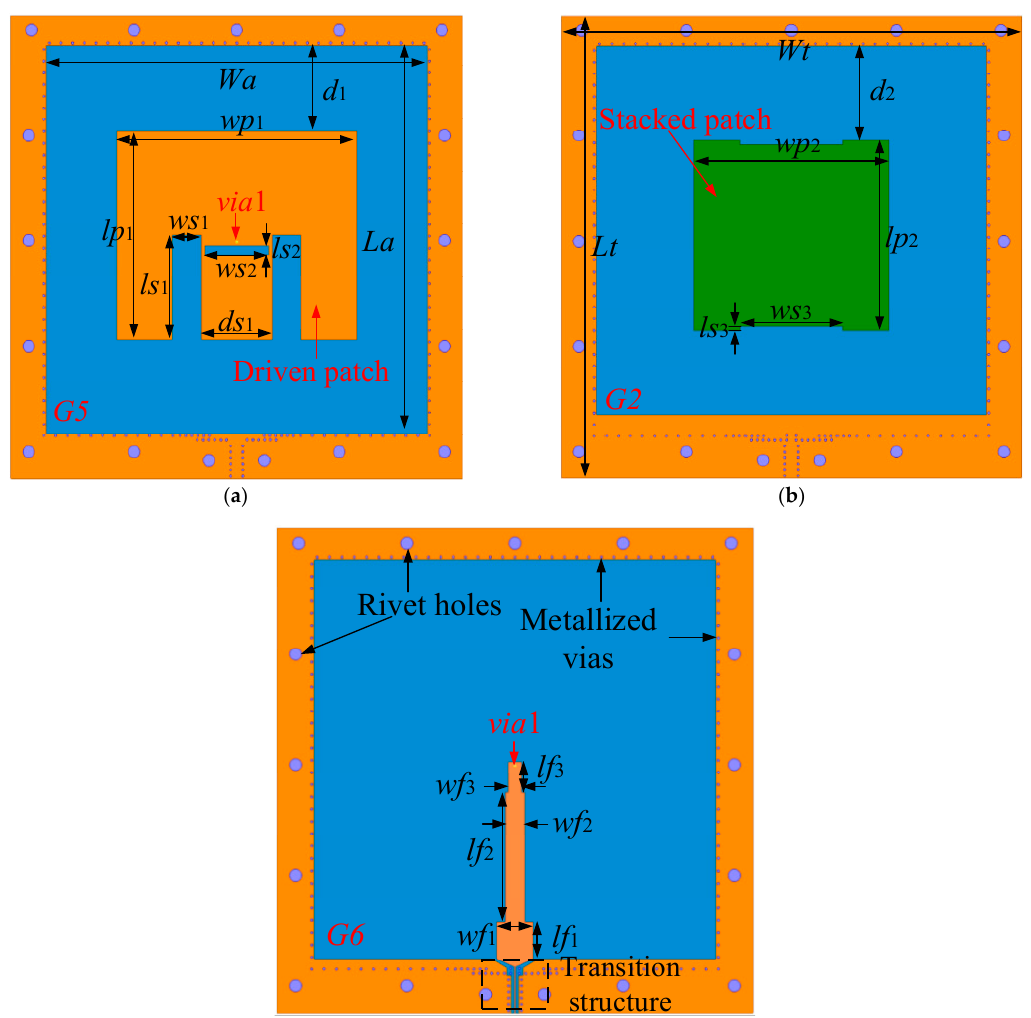
Figure 2. Configurations at each layer. ( a ) G5 layer; ( b ) G2 layer; ( c ) G6 layer.